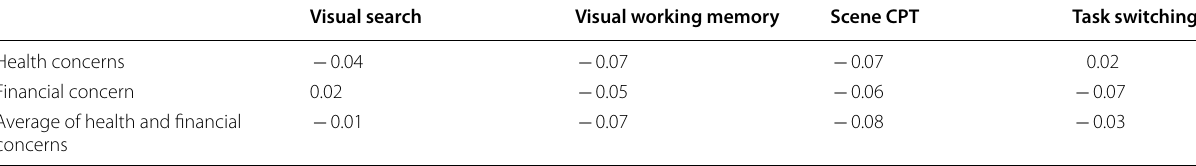
None of the correlations reached statistical significance